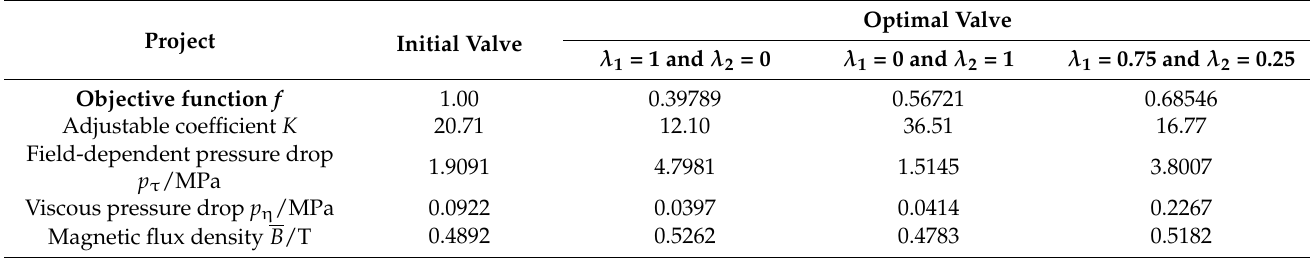
Table 1. Performance of the initial and optimal radial MR valve.